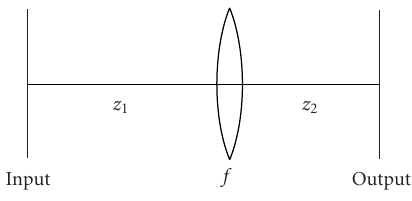
Figure 1: A typical optical information processing